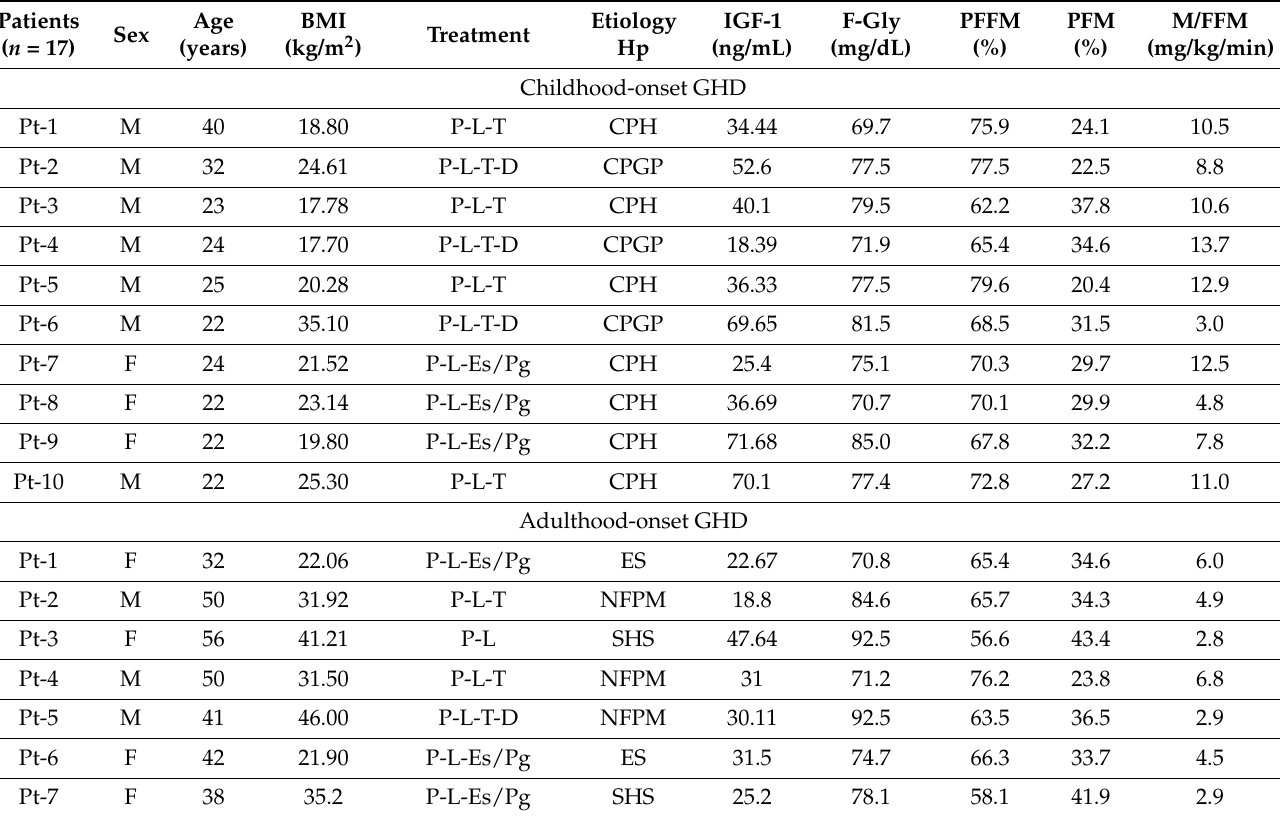
Table 1. Clinical characteristics, replacement therapy, etiology, laboratory findings, body composition, and insulin sensitivity parameters of each patient with childhood-onset and adult-onset